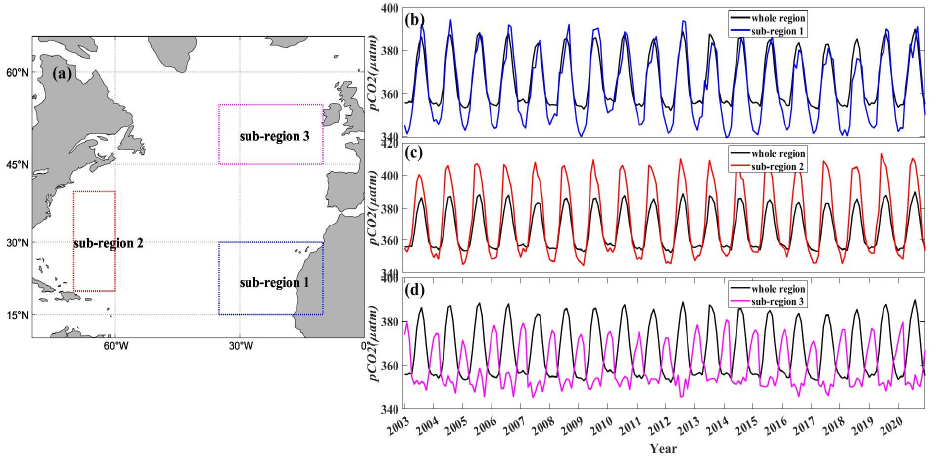
gion are also different.